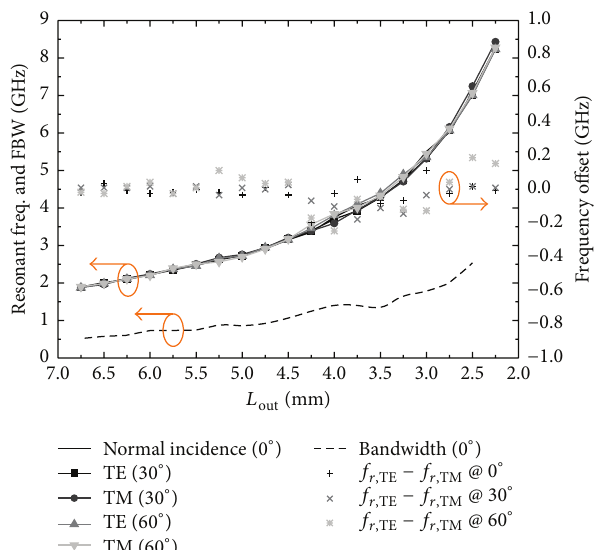
Figure 2: Resonant frequency, FBW, and frequency offset for 𝐿